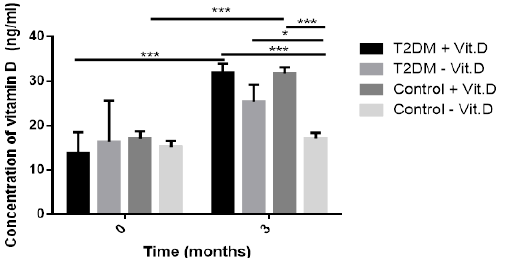
Figure 2. The serum level of vitamin D detected in patients with type 2 diabetes (T2DM) (T2DM + Vit. D, n = 18; T2DM – Vit. D, n = 14) and patients without T2DM (Control + Vit. D, n = 30; Control − Vit. D, n = 30) before and after three-month supplementation. Results are presented as mean ± SD (* p < 0.05; *** p < 0.001).